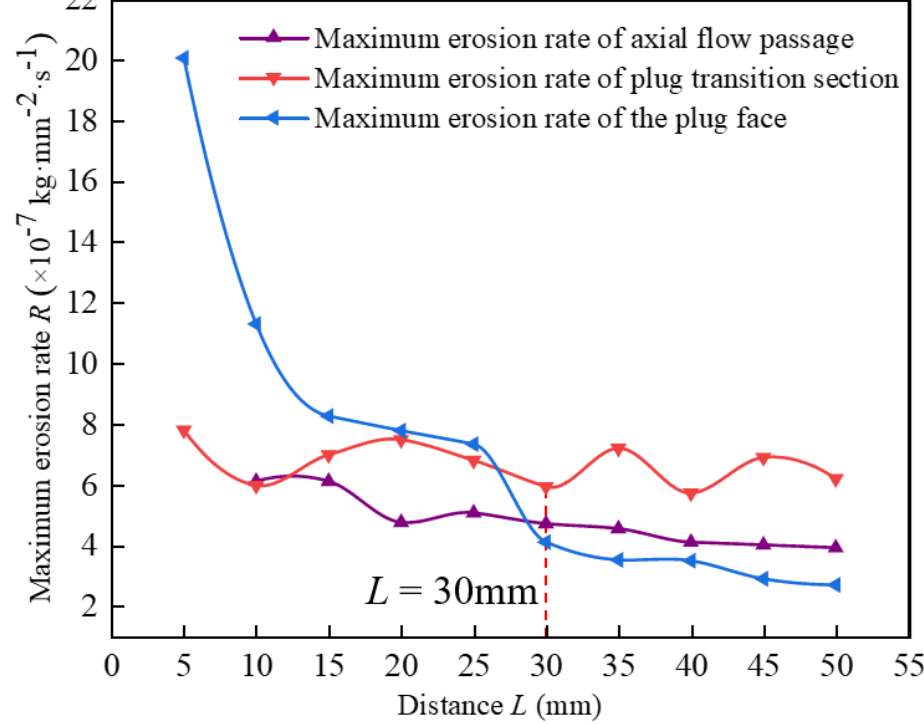
Figure 15. Maximum erosion rate changes with plug transition distance.